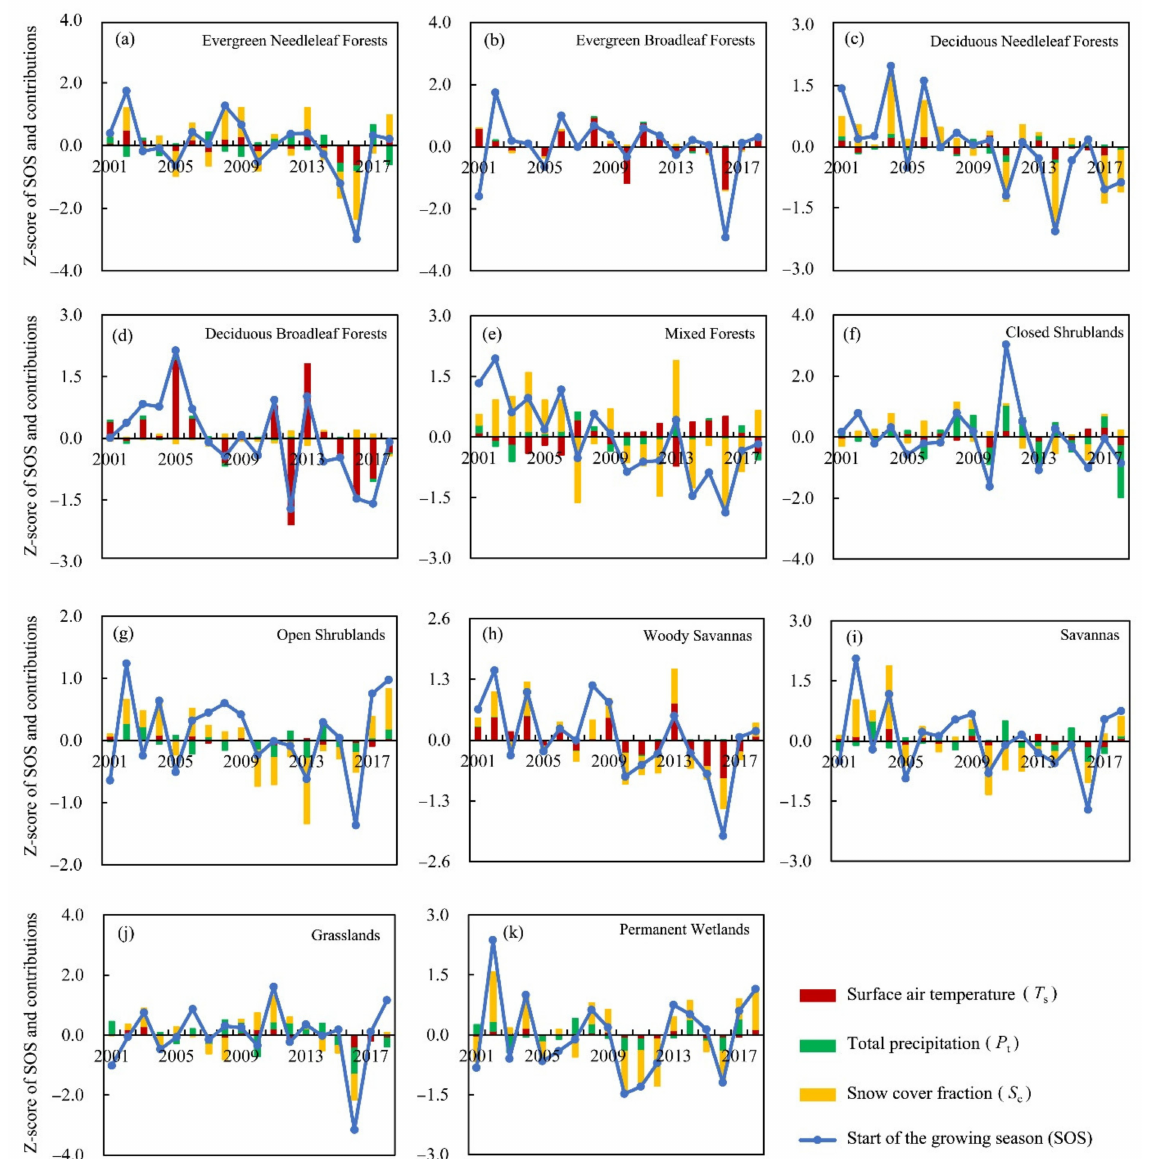
Figure 6. Contributions from T s , P t , and S c to SOS anomalies in ( a ) evergreen needleleaf forests, ( b ) evergreen broadleaf forests, ( c ) deciduous needleleaf forests, ( d ) deciduous broadleaf forests, ( e ) mixed forests, ( f ) closed shrublands, ( g ) open shrublands, ( h ) qoody savannas, ( i ) savannas, ( j ) grasslands, and ( k ) permanent wetlands for